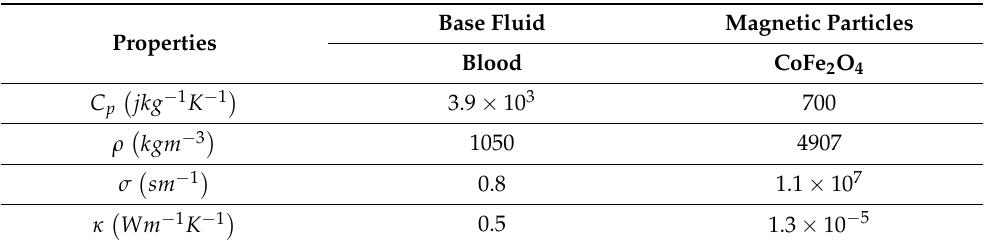
Table 4. The values of thermo-physical properties of magnetic particles and base fluid are as fol- lows